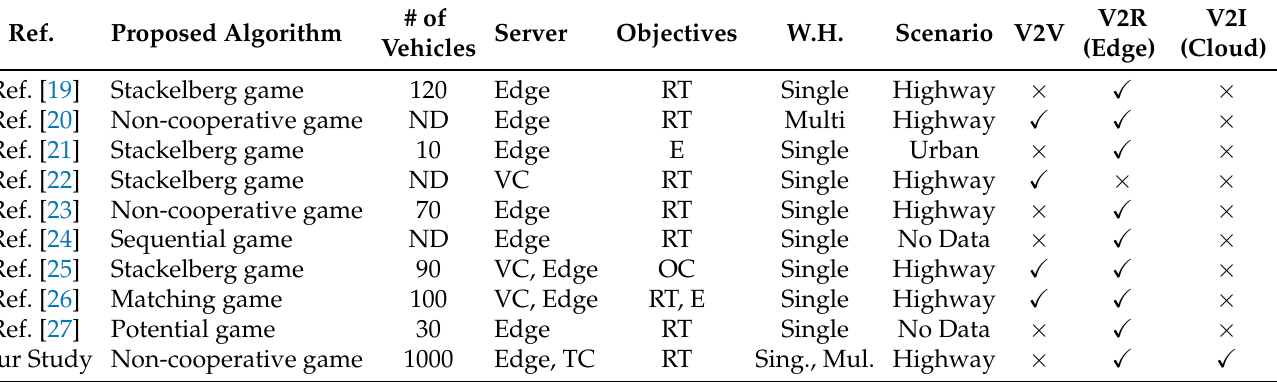
Table 1. Summary of the different game theory approaches for task offloading in MEC-enabled VEC